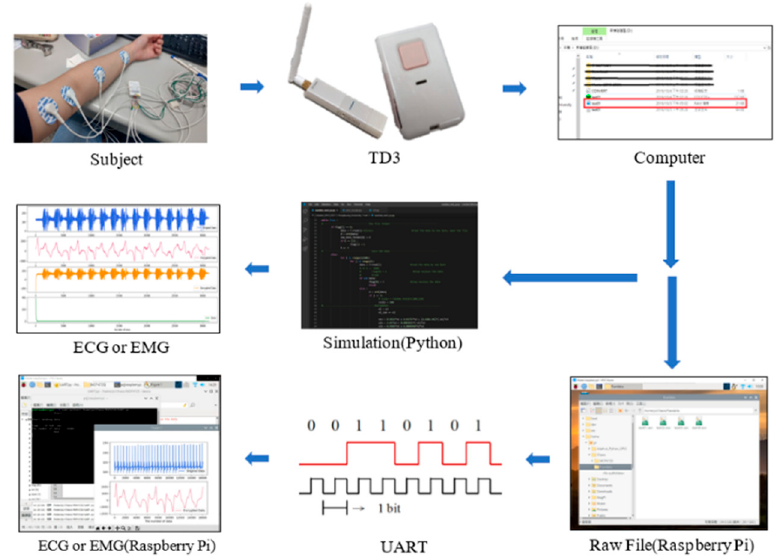
Figure 9. Architecture of the system.